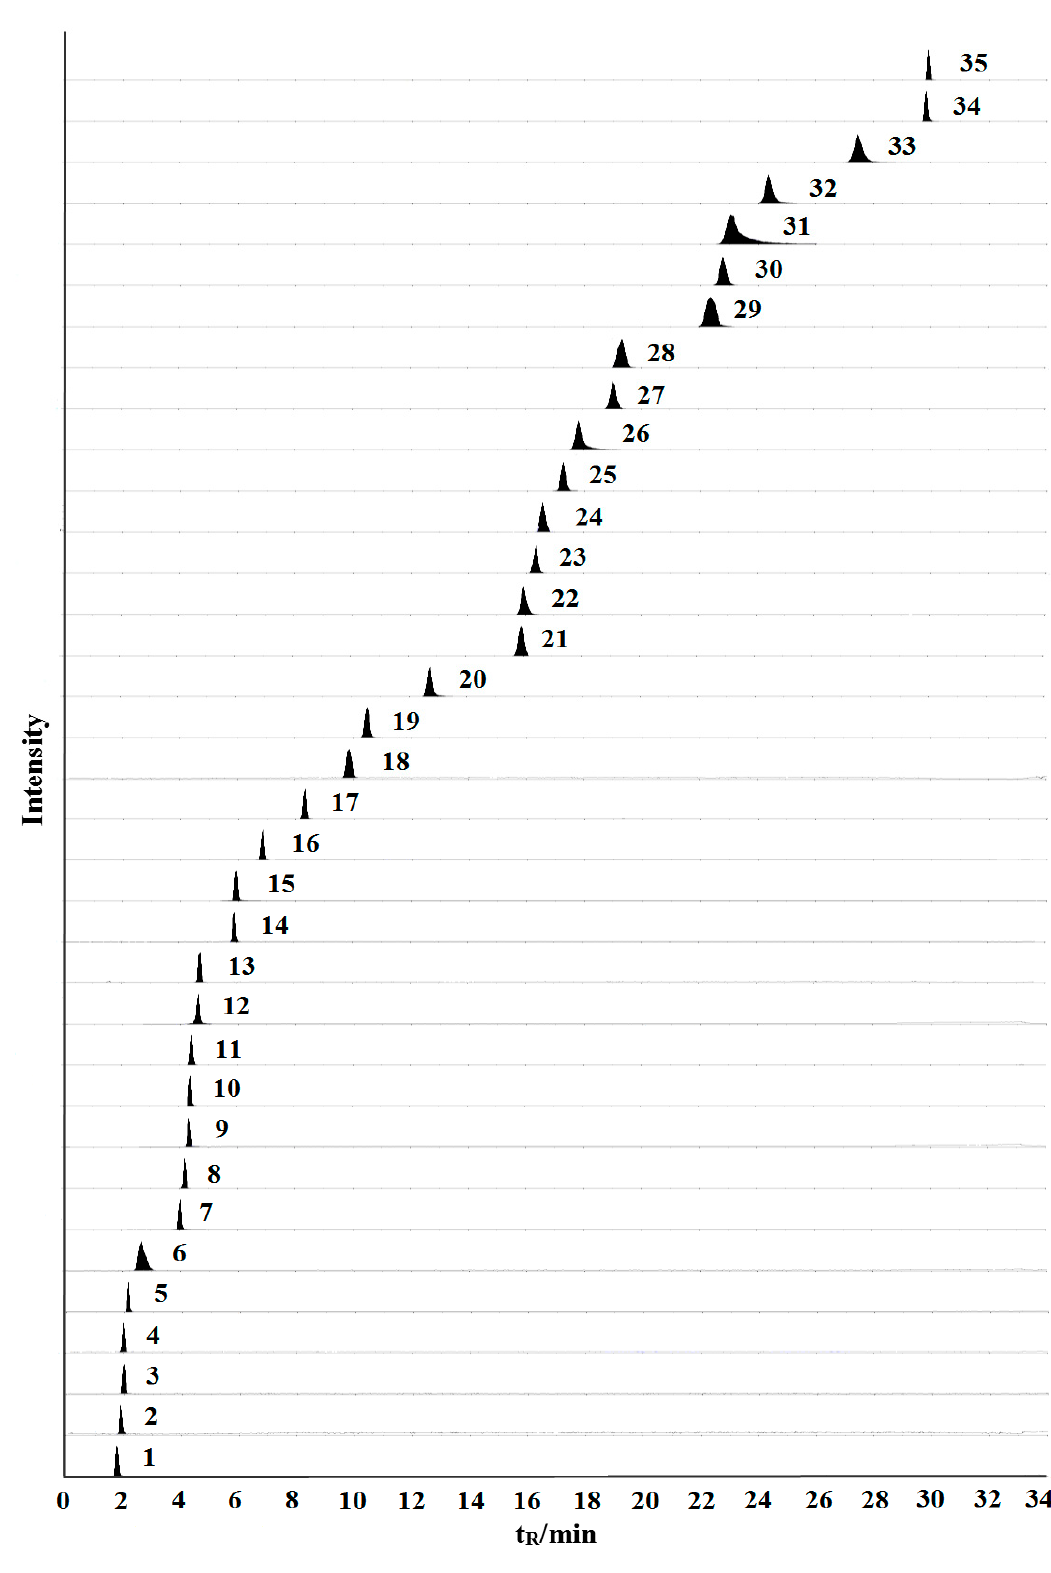
Figure 1. Representative extract ion chromatograms (XIC) of multiple-reaction monitoring (MRM) chromatograms of the 35 investigated constituents. (The peak numbers denoted are the same as those in Table